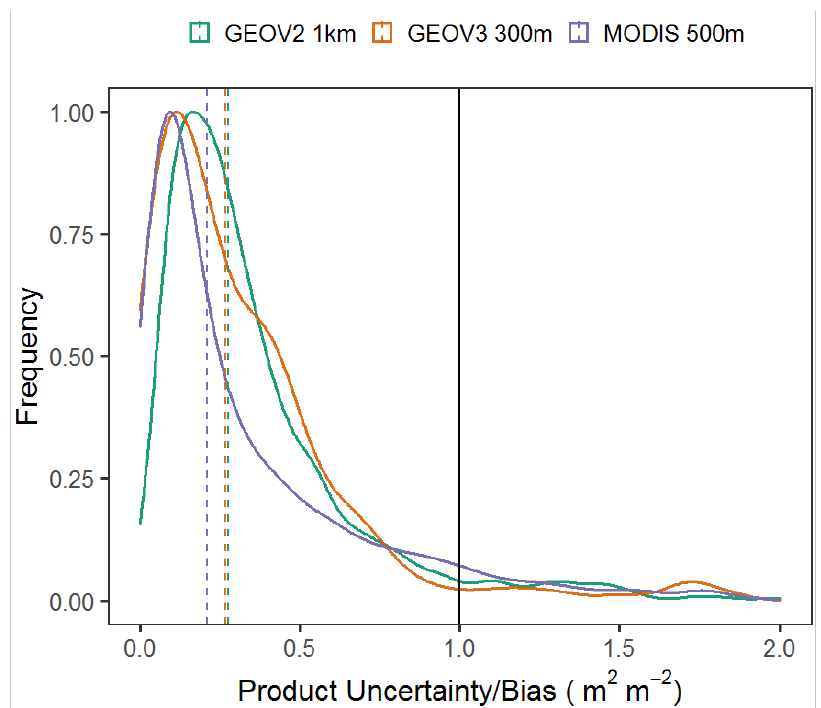
Figure 4. Distribution of the ratio of EO uncertainty estimates to bias, based on a comparison against in situ LAI measurements. Dashed lines represent the median values and the color represents different EO products. The vertical black line is the reference line where the ratio is equal to 1. A ratio larger than 1 indicates the uncertainty estimate is larger than the bias and is therefore considered robust.